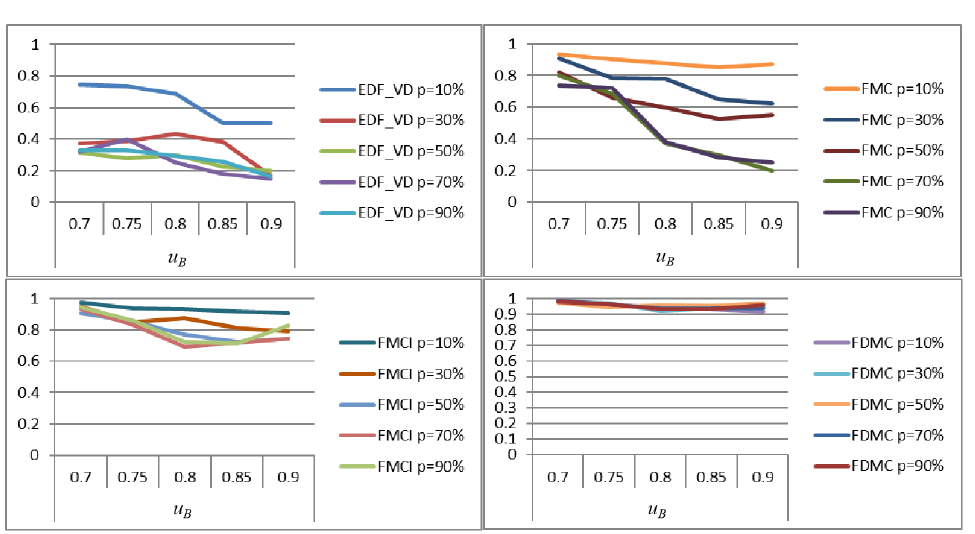
Figure 7. The PFJ evaluation of each scheme under different p values.